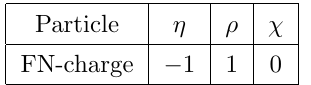
Table 1 . The FN U(1) charges of the